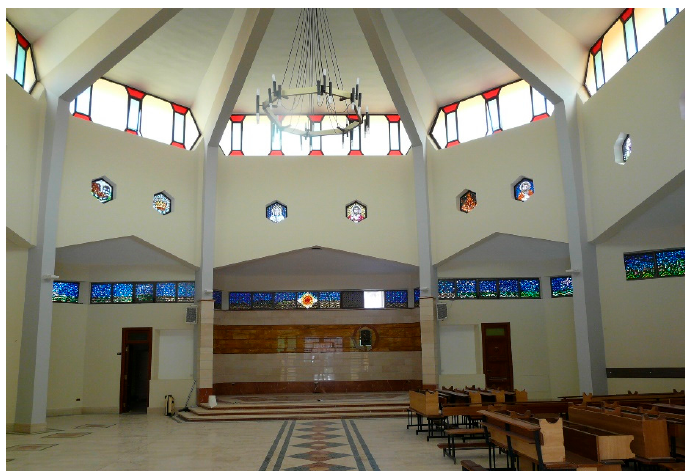
Figure 1. Interior of the church.